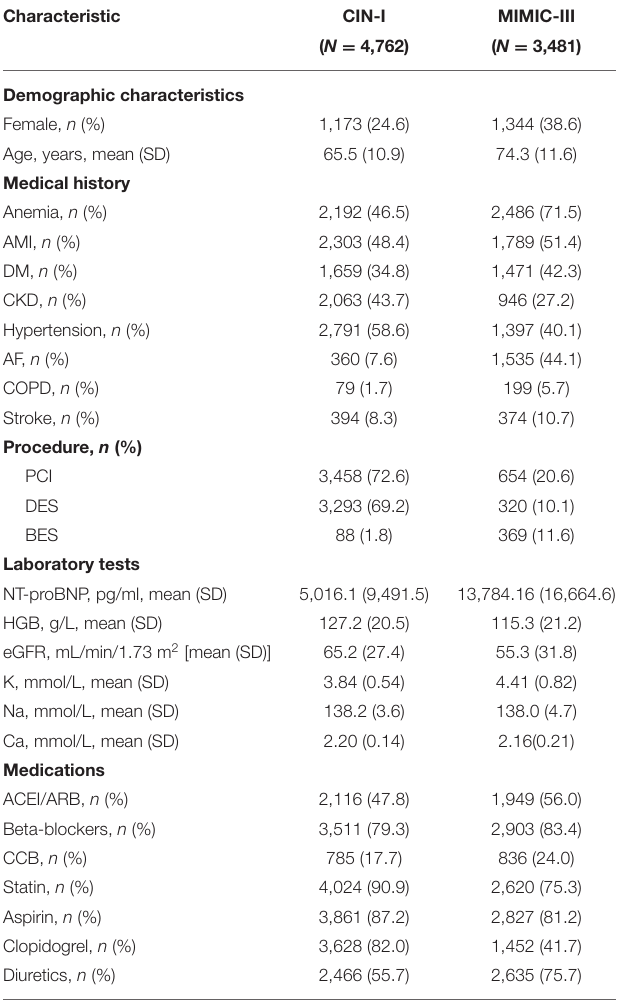
TABLE 1 | Baseline characteristics of the included patients in a registry of Cardiorenal Improvement (NCT04407936) (CIN-I) and Medical Information Mart for Intensive Care